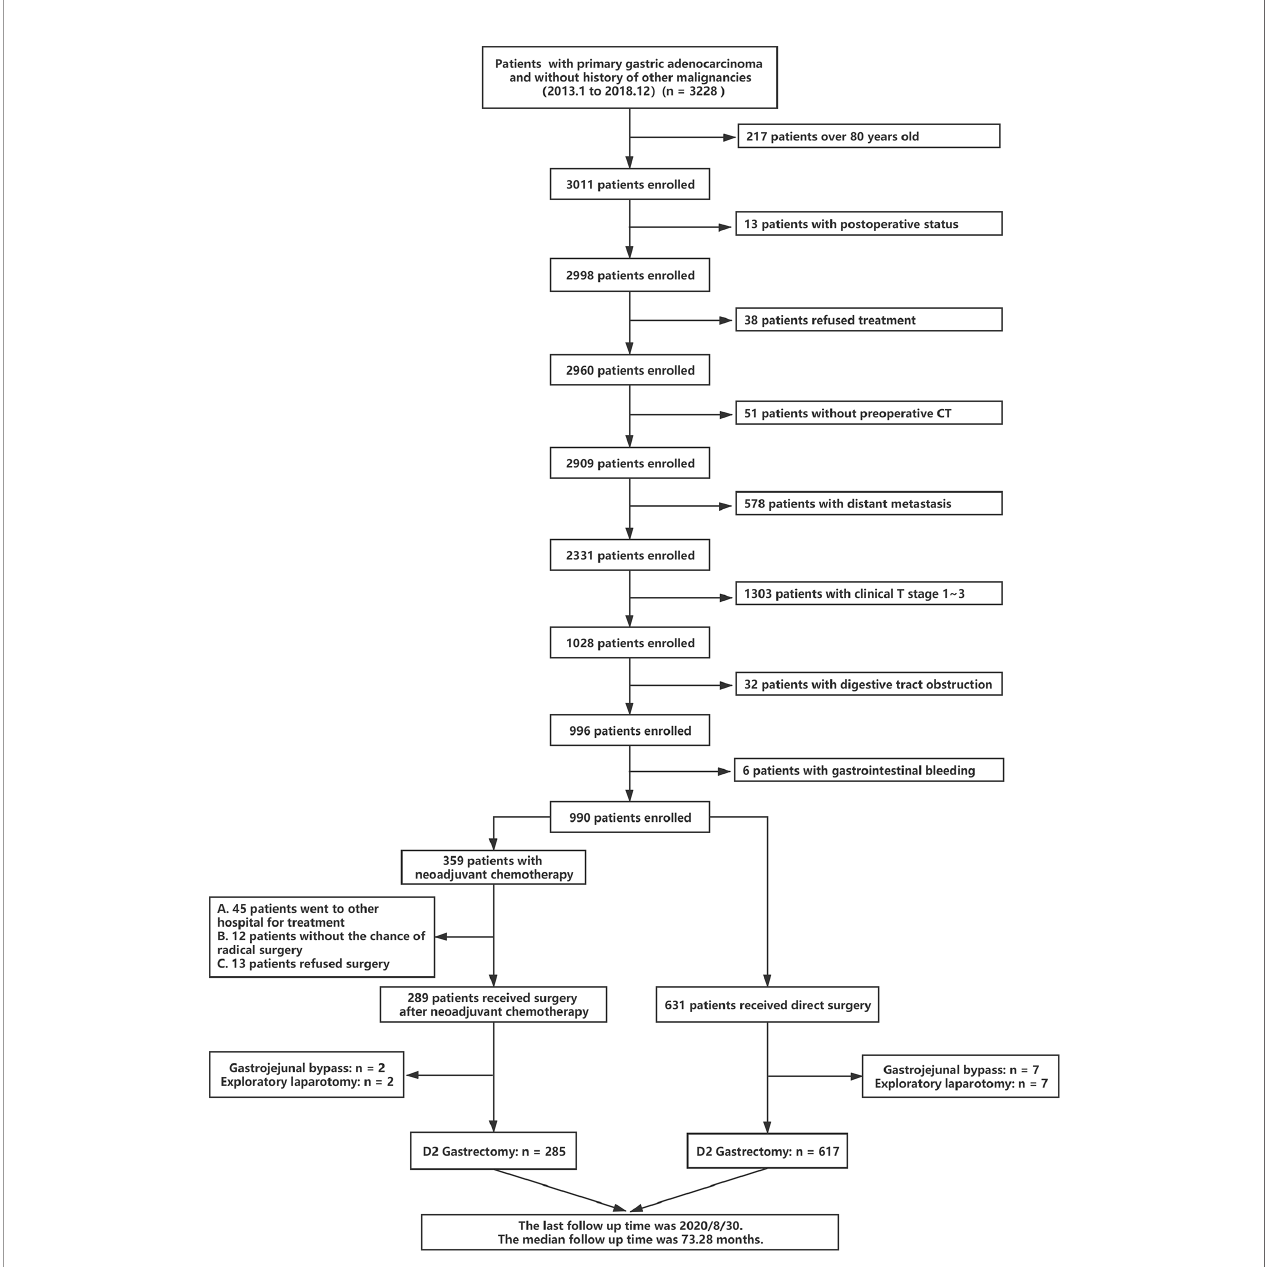
FIGURE 1 | Flowchart of patient selection